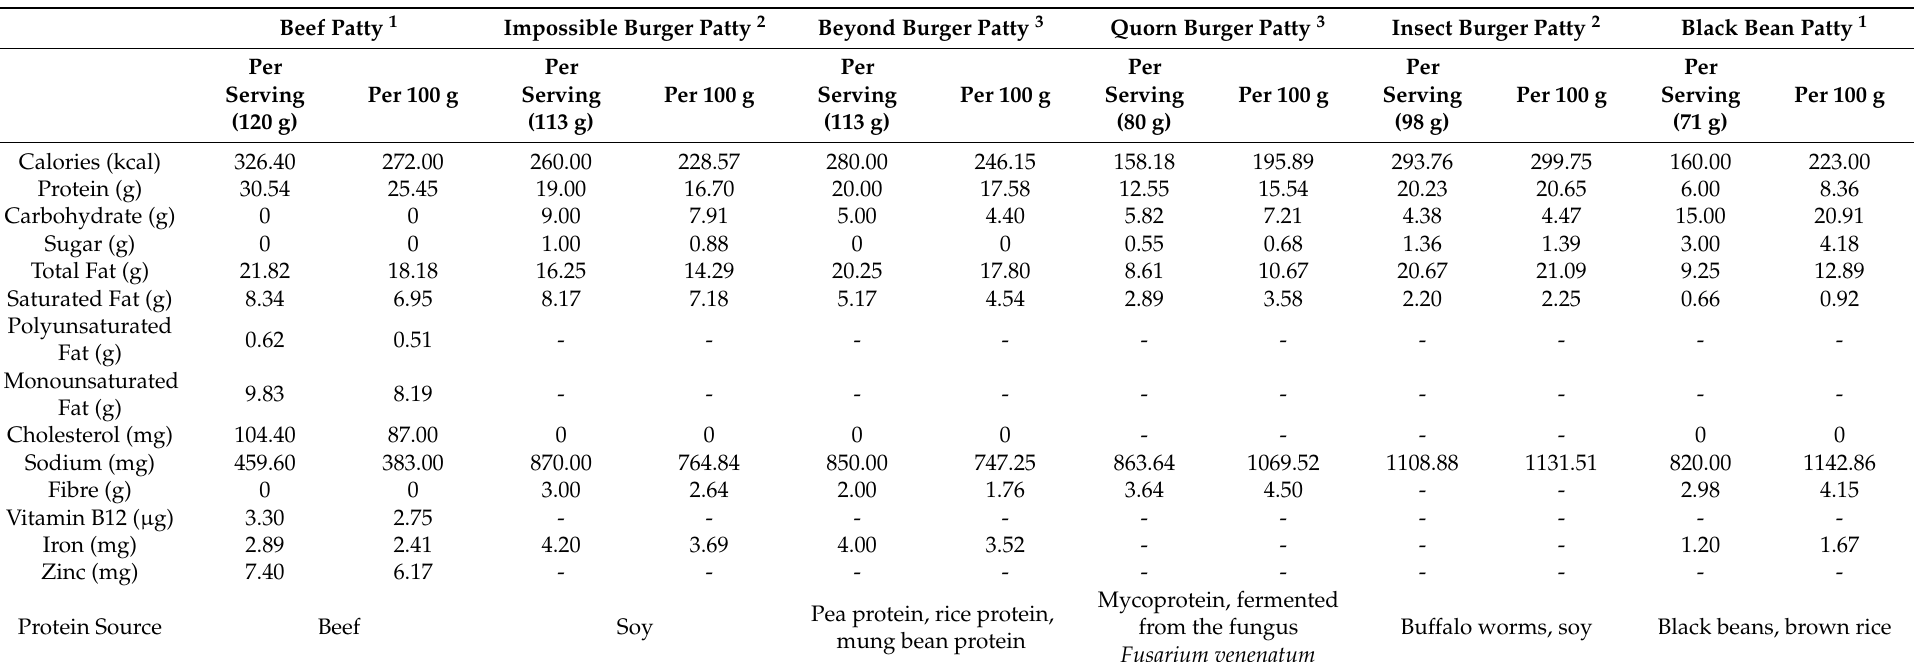
Table 5. Comparison of animal- and plant-based burger patties